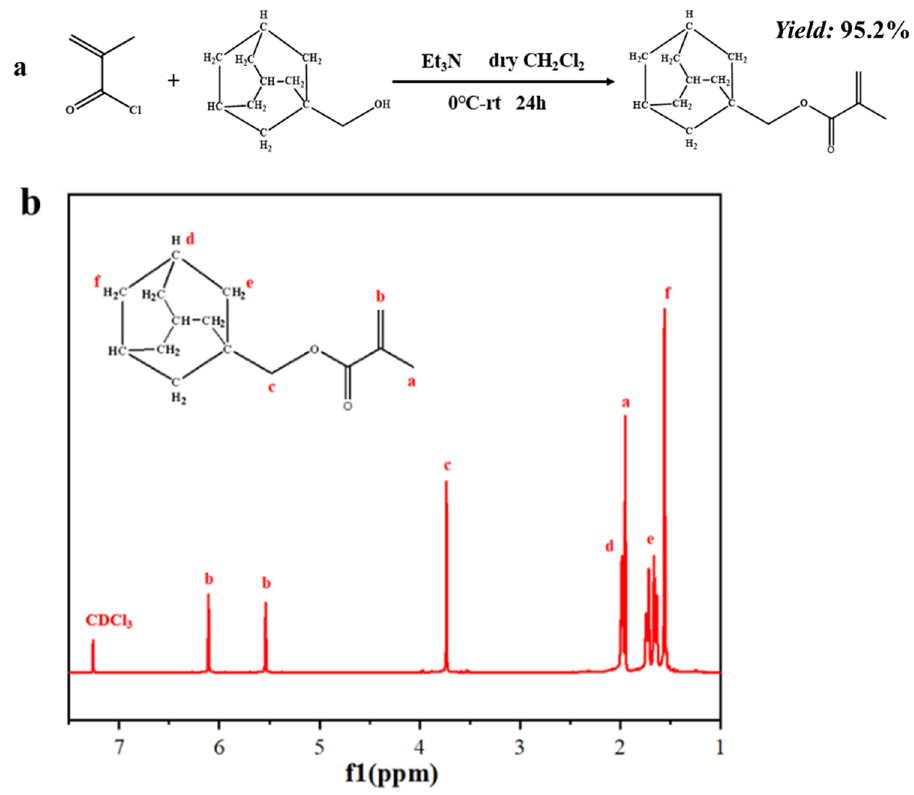
Figure 1. ( a ) The schematic illustration of the synthesis of AdaMMA; ( b ) 1 H-NMR spectra of AdaMMA (in deuterochloroform). AdaMMA (in